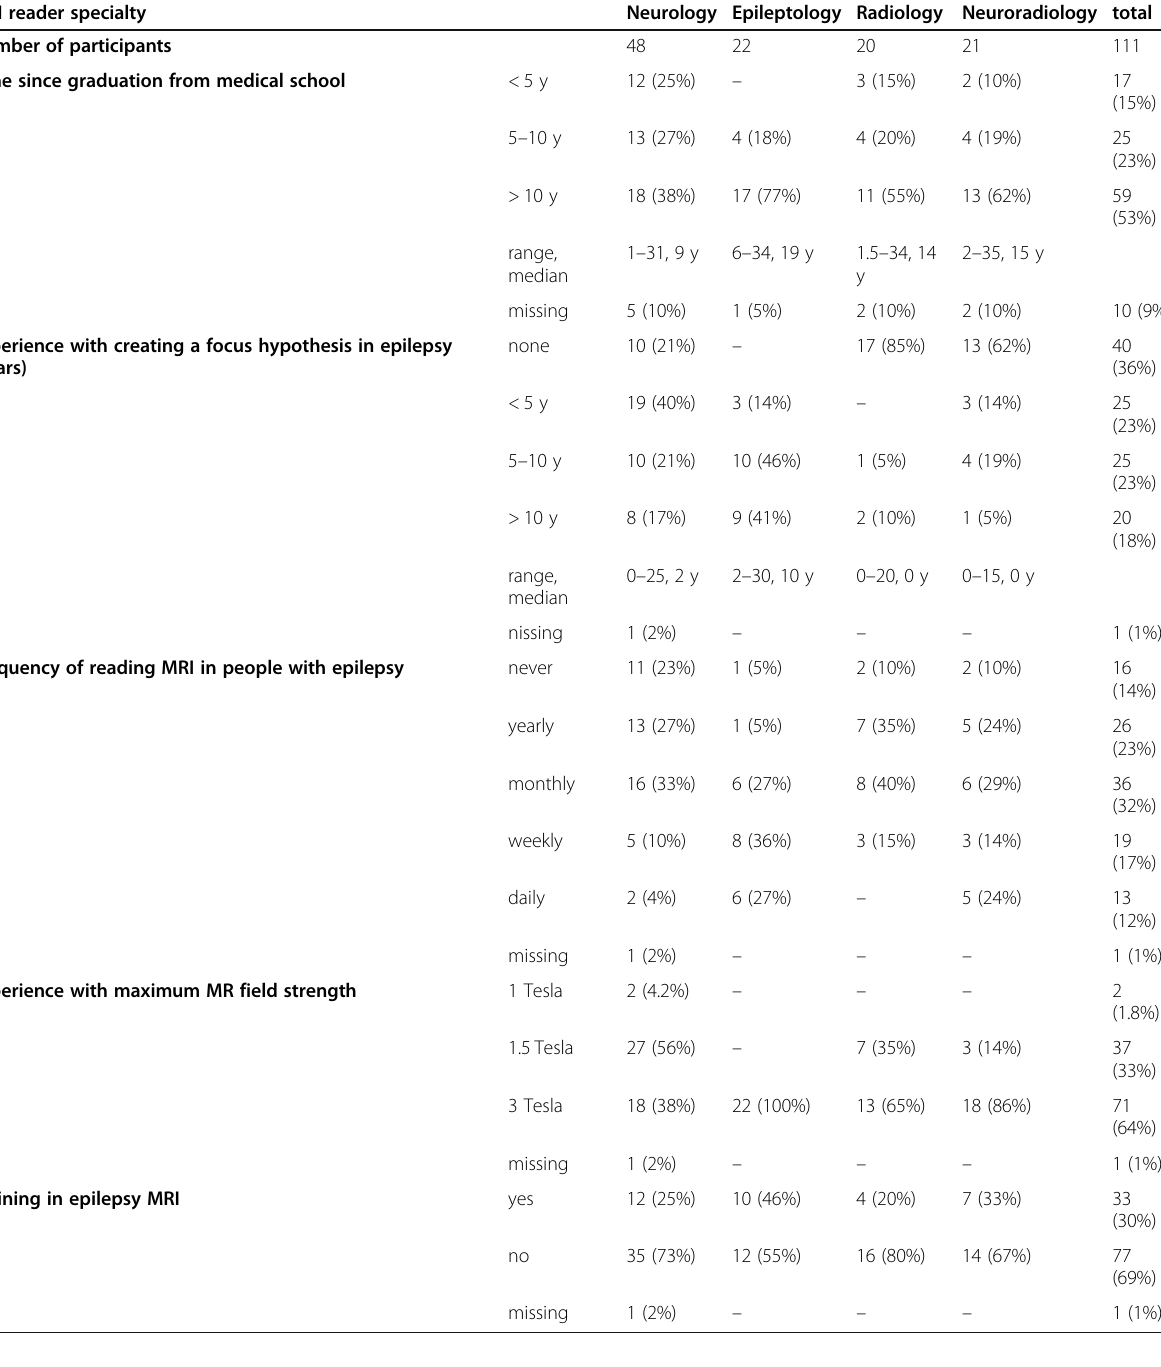
Table 1 Self - reported professional details of participants. Missing data were not provided by participants MRI reader